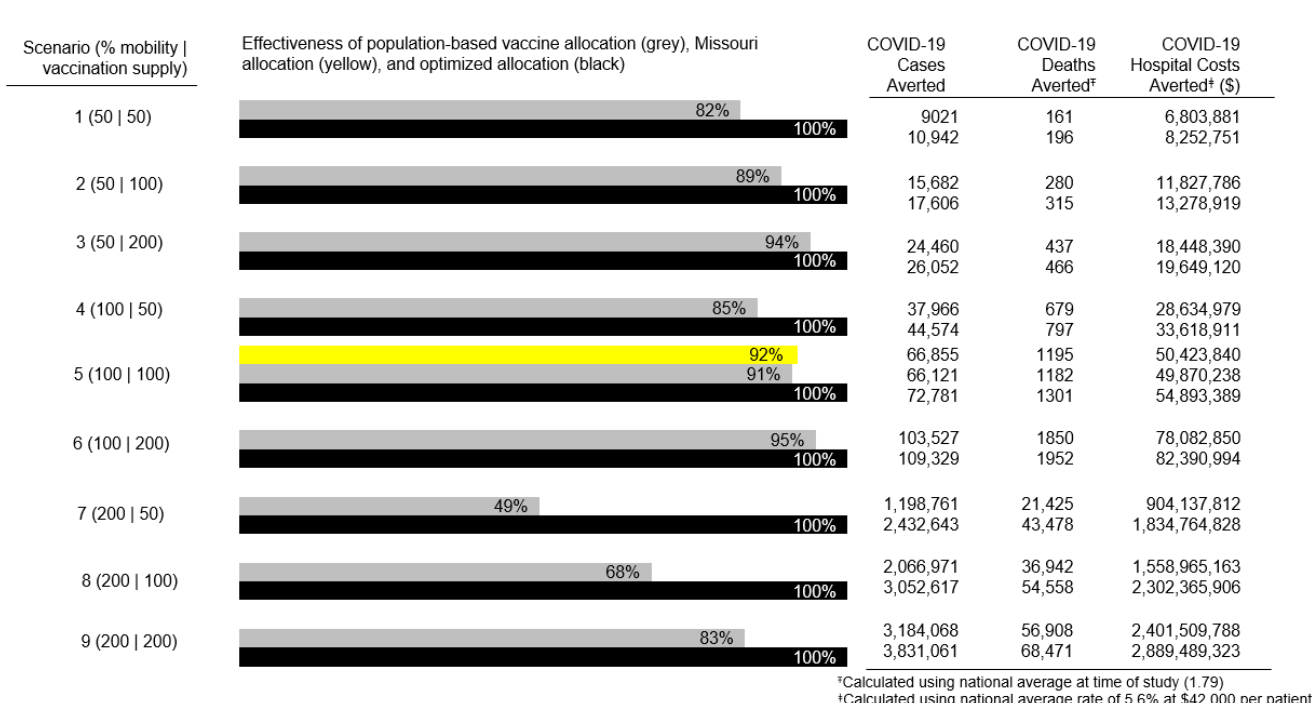
Figure 2. Effectiveness of population-based vaccine allocation and Missouri state allocation compared to spatially optimized allocation under 9 different scenarios of varying geographic mobility.